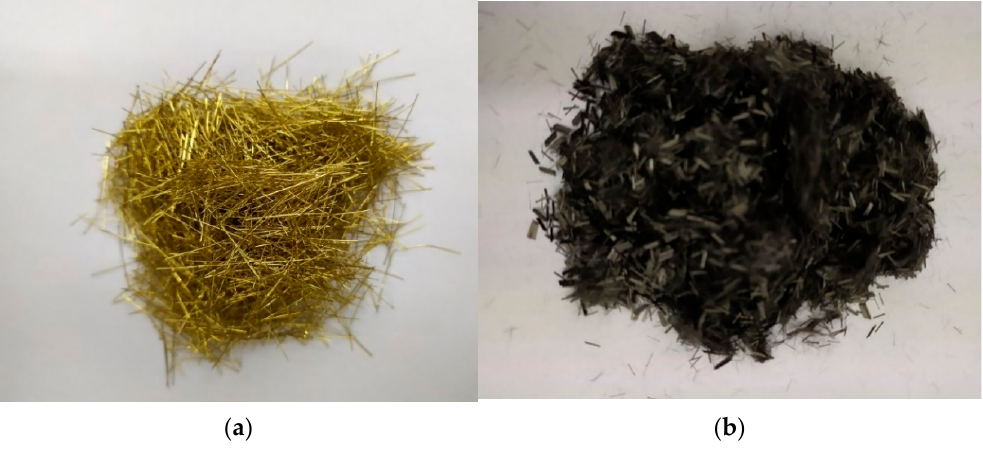
Figure 4. ( a ) Steel fibre; ( b ) Carbon fibre.